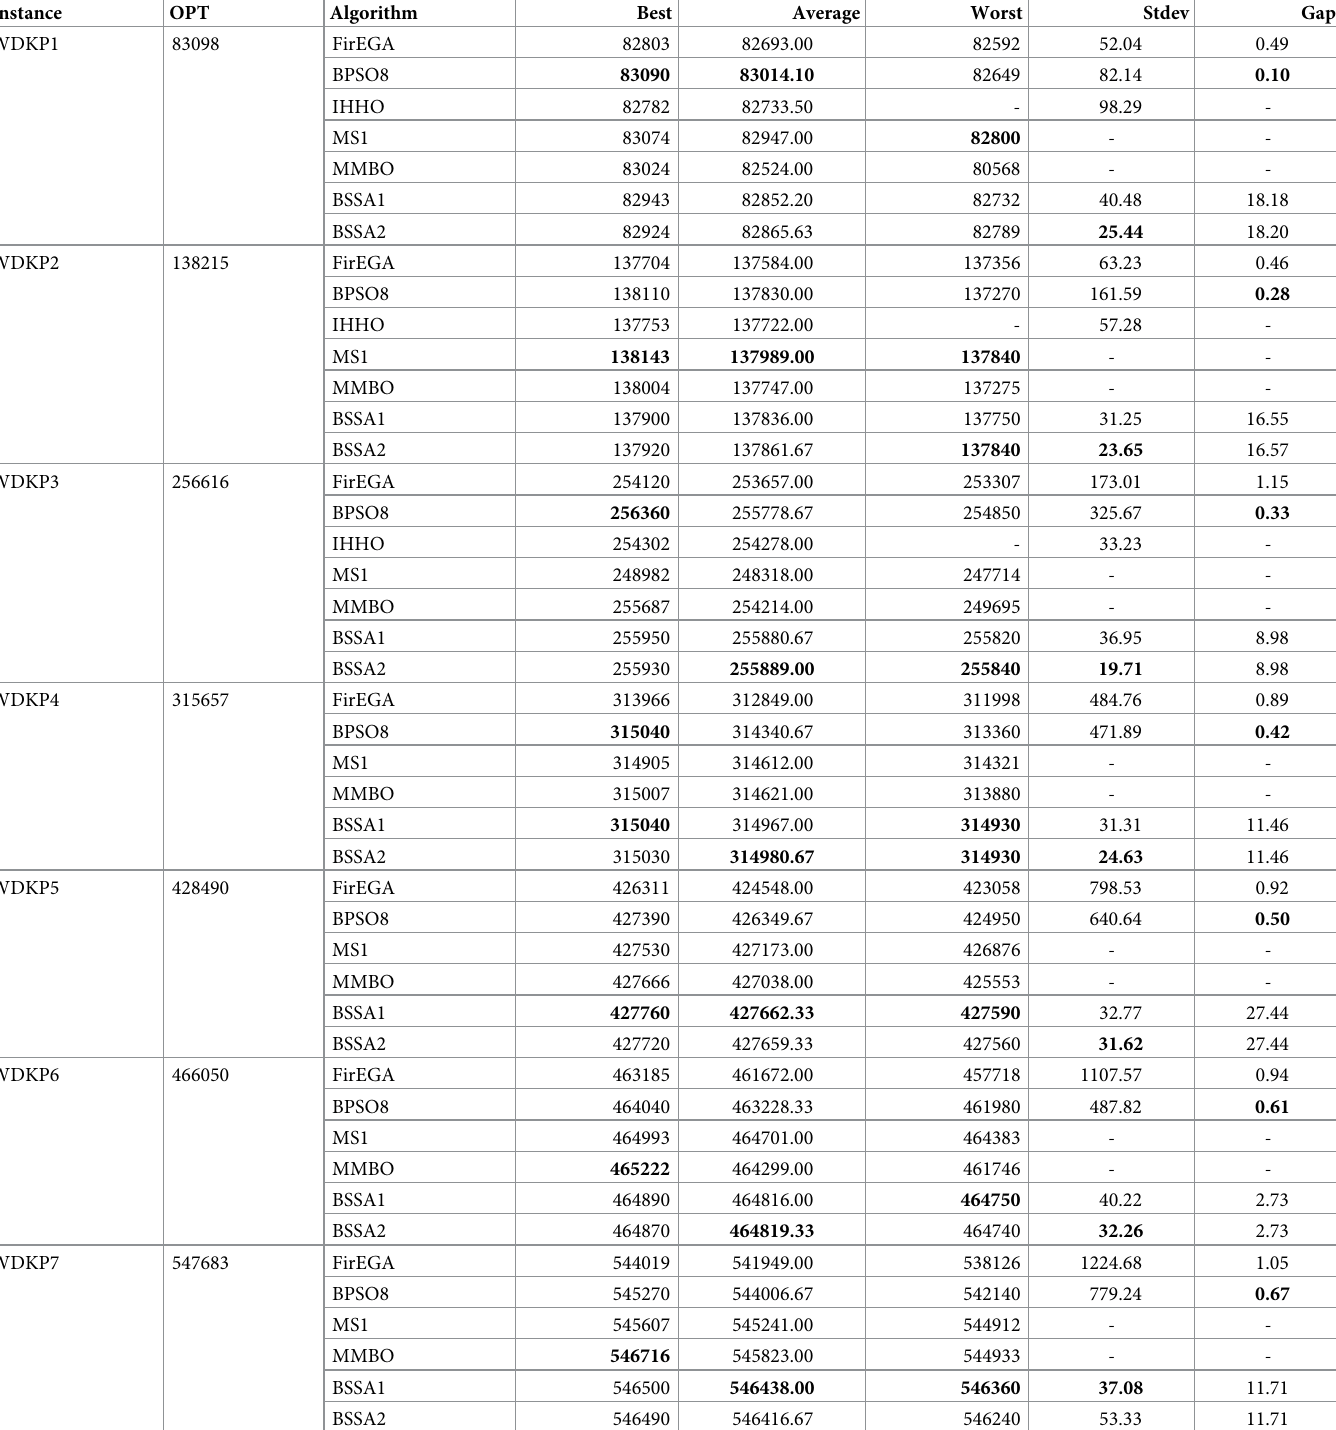
Table 8. Test results with weakly correlated